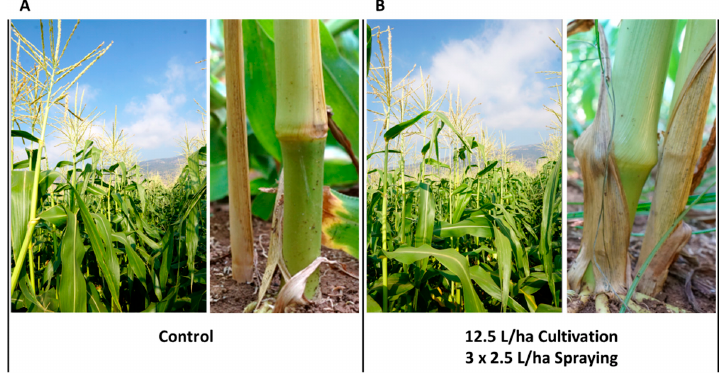
Figure 1. Photograph of the field experiment and stem surface symptoms (Neot Mordechai, spring 2018). Photograph of representative plots of the control ( A ) and the most intensive treatment, 12.5 L/hectare spraying during land tillage, and later three dosages of 2.5 L/hectare ( B ) at the end of the growth season (73 DAS, 18 days after fertilization, DAF) demonstrating that the plants of the entire experimental field had a healthy appearance and typical development. Close inspection of the Jubilee cultivars’ lower stems (near the first above-ground internode) revealed mild symptoms. The stem surface symptoms included partial and occasional color alternation (from green to yellow or brown) of the first above-ground internode and dehydration of the first one or two leaves.